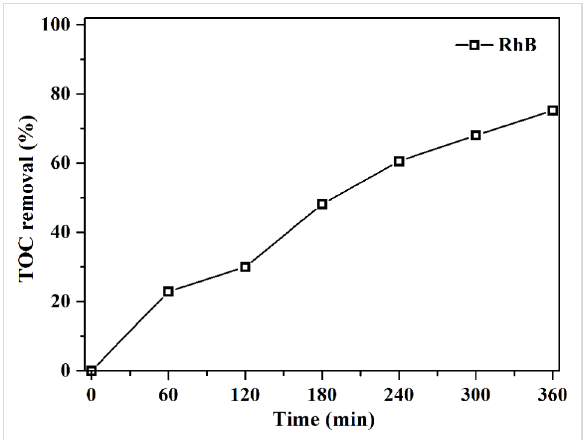
Figure 7: Total organic carbon (TOC) removal during the photocatalyt- ic degradation of RhB in the presence of 0.3AgI/Ag 2 WO 4 .